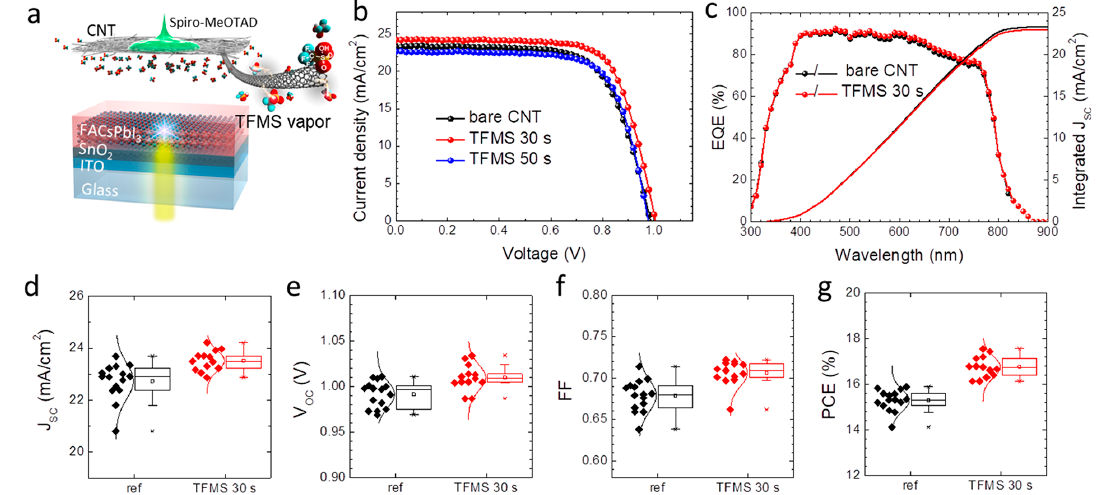
Figure 5. ( a ) Schematic illustration of planar heterojunction PSCs based on TFMS-doped CNT. ( b ) J − V curves of the highest PCE PSCs, incorporating bare CNT and CNT doped by TFMS 30 and 50 s. ( c ) EQE spectra and corresponding integrated short-circuit current density ( J SC ) of the device based on bare CNT and CNT doped by TFMS for 30 s. ( d ) J SC . ( e ) open circuit voltage ( V OC ). ( f ) fill factor (FF) and ( g ) PCE of the PSCs incorporating bare CNT and CNT doped by TFMS [218] 2019 American Chemical Society.